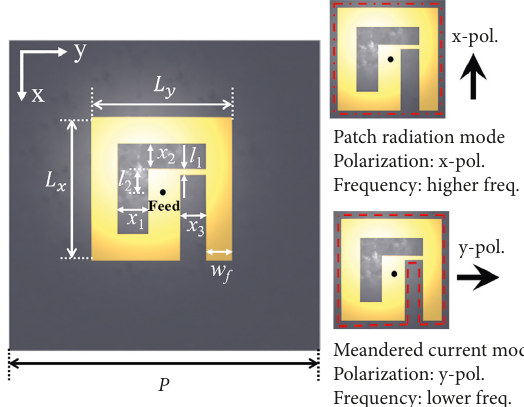
Figure 1: Geometry of the proposed antenna ( p �